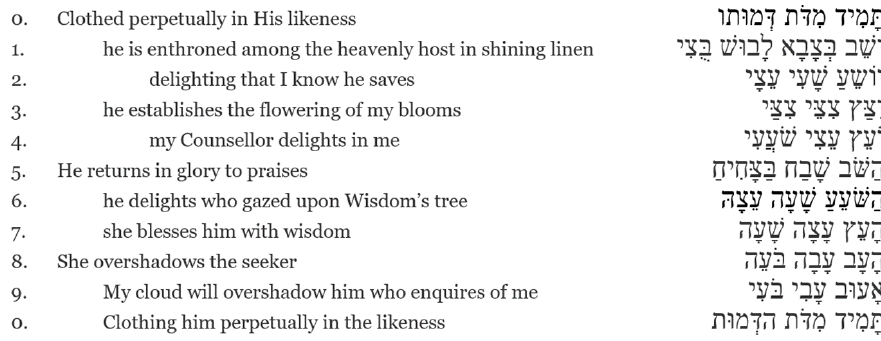
Figure 2. “Menorah” page from a Lead Book. Image (left) courtesy of Jean-Paul Bragard. Tracing (right) by Margaret Barker. See Supplementary Materials for more